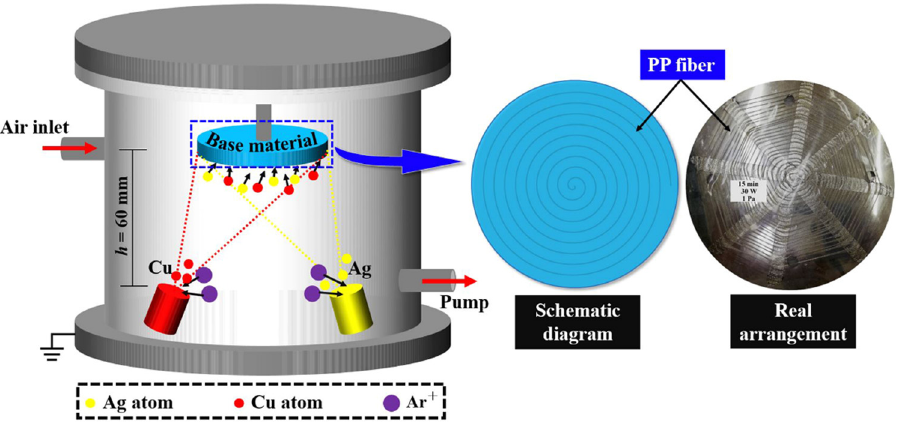
Figure 1: The formation of Cu/Ag nanoparticles over PP surface by magnetron sputtering